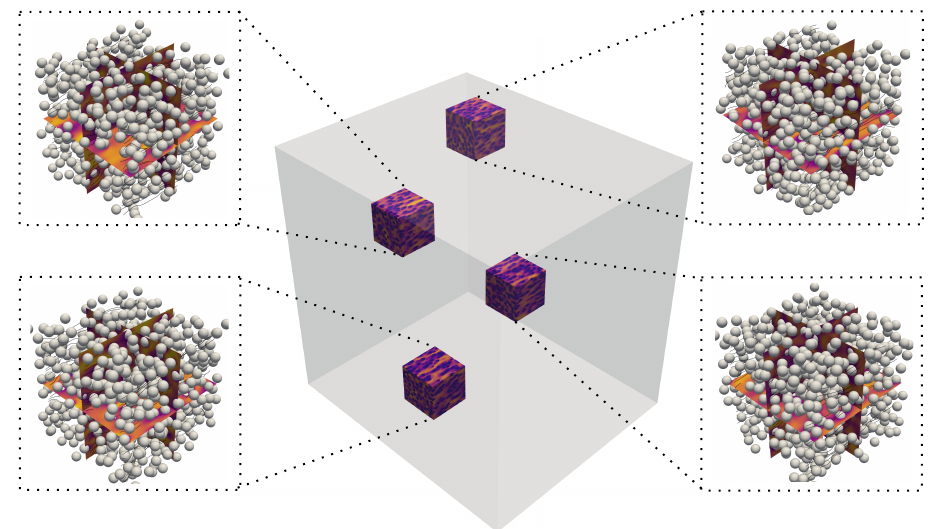
Figure 28. Flow visualization in multiple sub-domains at the steady state. The streamlines and rigid spheres for each sub-domain are shown in the